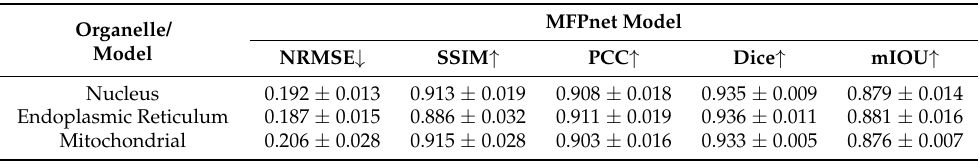
Table 1. Comparison of quality measures for label-free prediction results with MPFnet model. Here, ↓ indicates that the lower the index value, the better the performance; ↑ indicates that the higher the index value, the better the performance of the model.